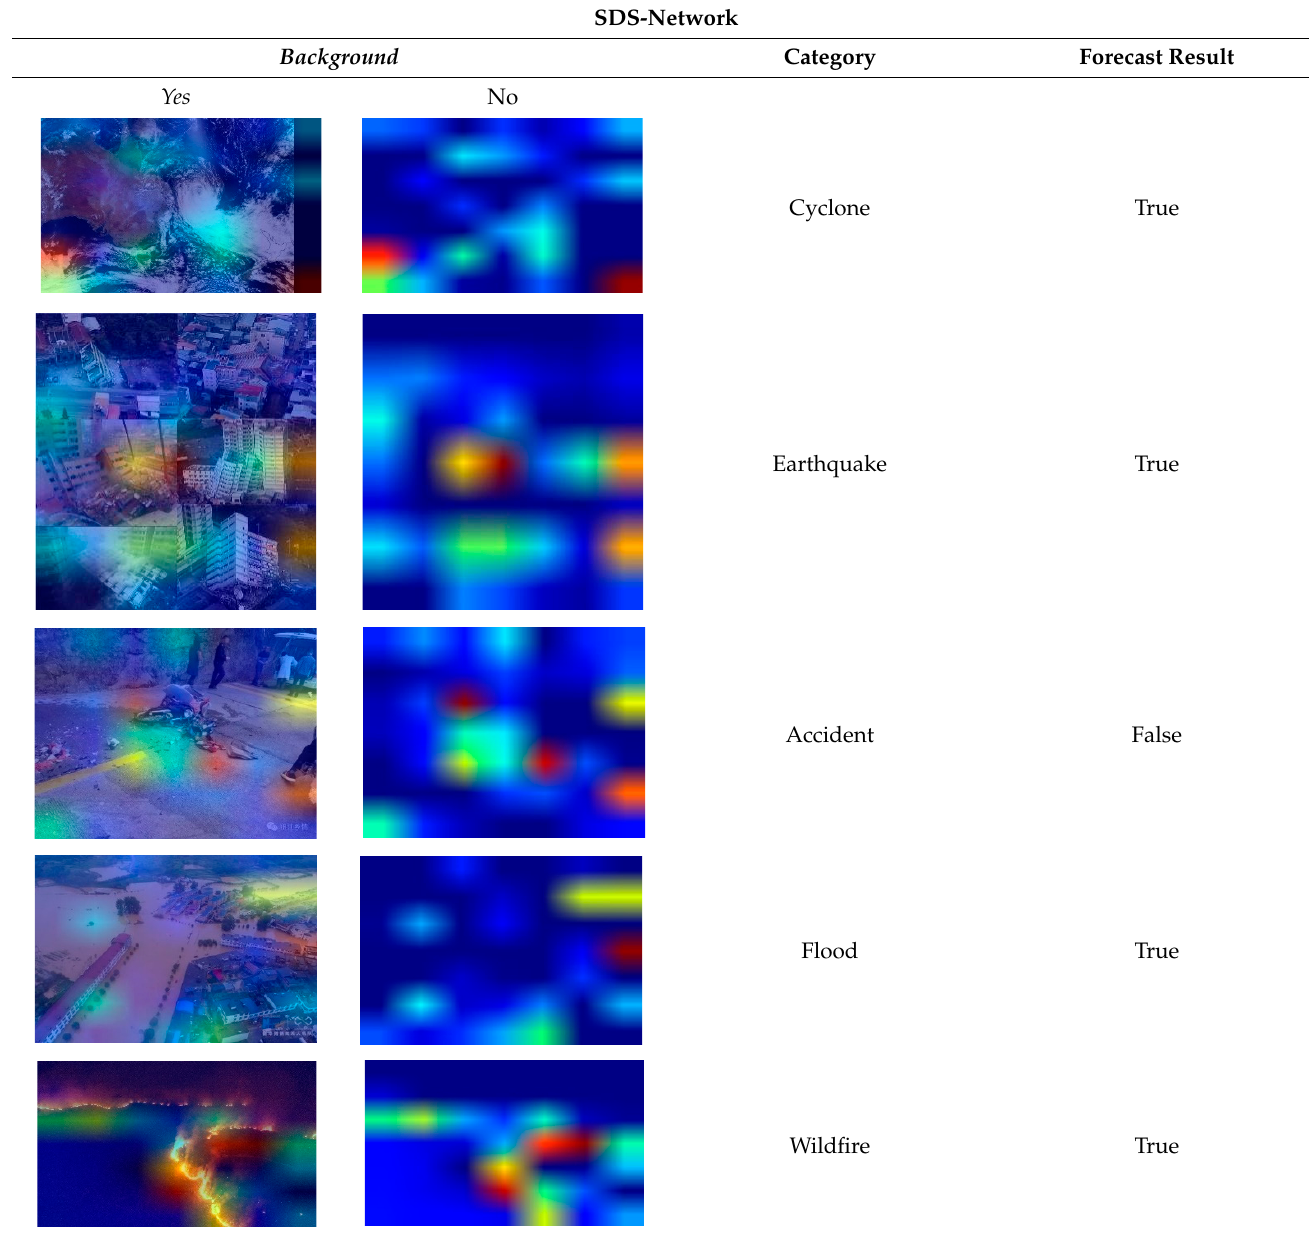
Table 8. Grad-CAM data visualization table.